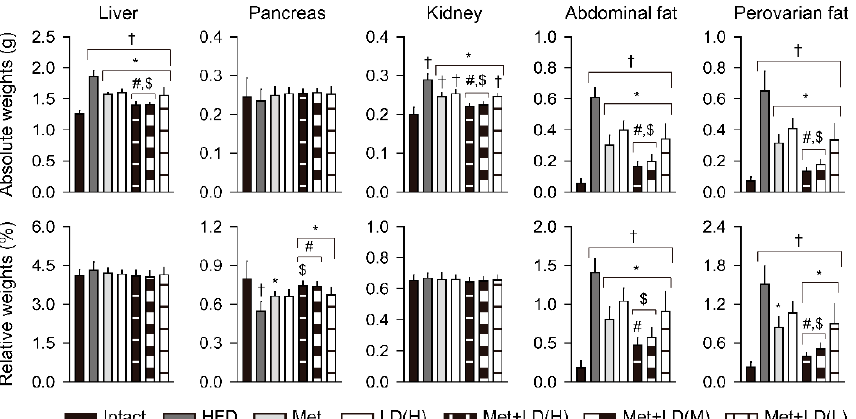
Figure 3. Combination effects on HFD-induced organ weights. Absolute organ weights of the liver, pancreas, kidney, and abdominal/periovarian fat mass, and the relative weights to the body weights, are represented as the means ± SDs ( n = 8). †, *, #, and $: p < 0.05 vs. the Intact, HFD control (HFD), Met, and LD(H) groups, respectively.